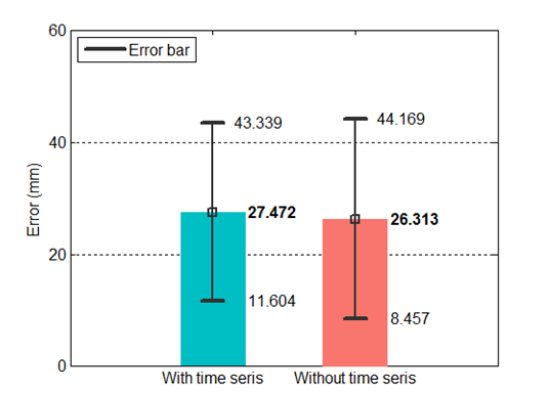
Figure 19. Prediction error of the proposed dual-network method with and without time stamps.